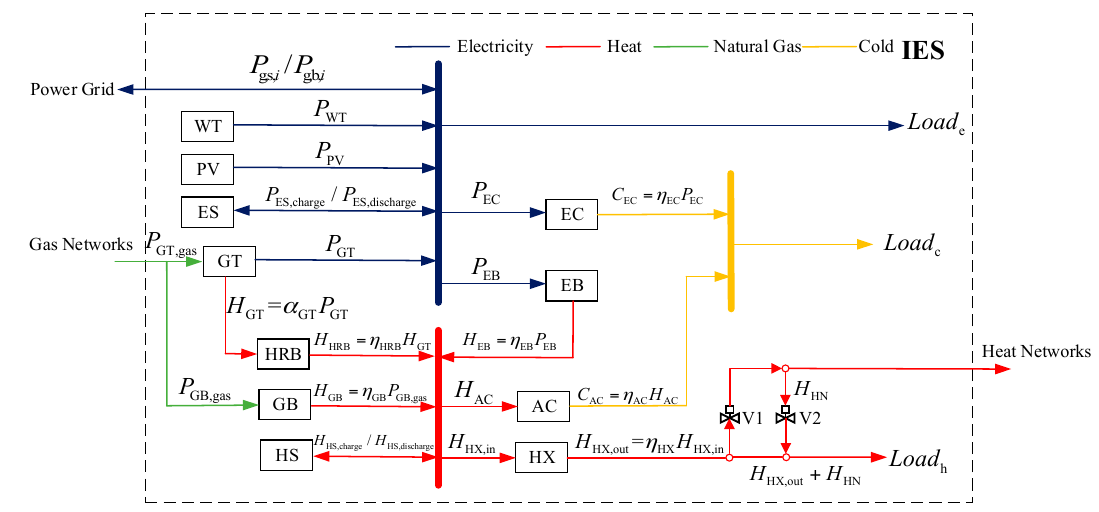
Figure 4. Coupling structure of IES and heating network.